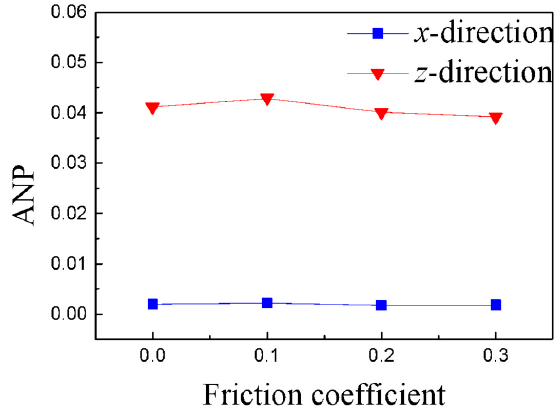
Figure 16. ANP versus friction coefficient ( c = 0.002).